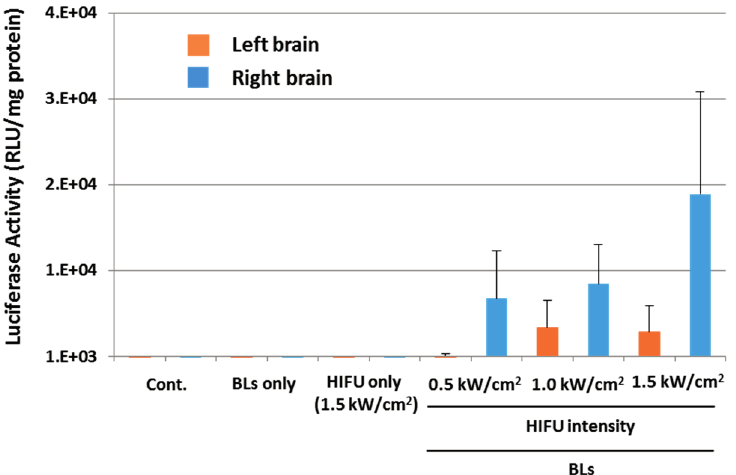
Figure 7. Delivery of plasmid DNA into the brain using the combination of BLs and HIFU exposure. Plasmid DNA encoding the luciferase gene and BLs were intravenously injected into mice, and the right hemispheres were exposed to 3.5 MHz pulsed HIFU conditions (intensity: 0.5–1.5 kW/cm 2 , exposure time: 30 s). Each tissue was corrected 24 h after the treatment, and the luciferase gene expression was determined. The activity is indicated by the relative light units (RLU) per mg of protein. Each value represents the mean S.D. ( n = 3). BL: Bubble liposomes.